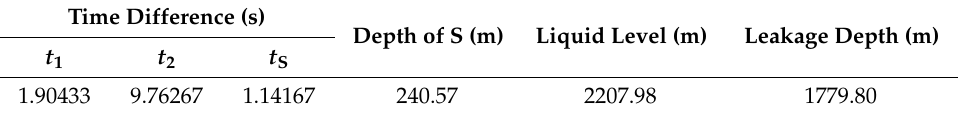
Table 4. Leakage localization results of field testing.